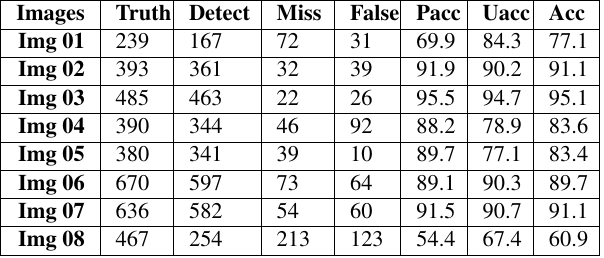
Table 3: Detection results on all images with CAPS, δ = 40 px